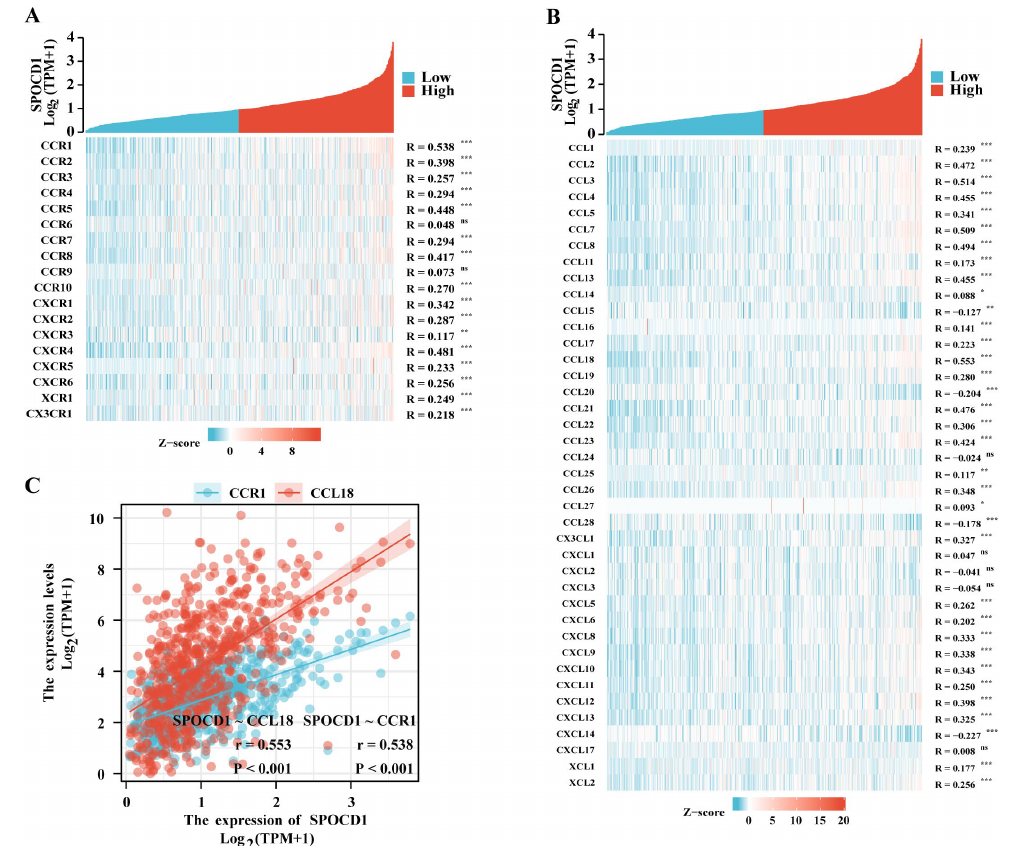
Figure 7. Correlation analysis between SPOCD1 expression and chemokines and chemokine receptors in CRC. ( A ) Heatmap analysis of the correlation between SPOCD1 and chemokine receptors in tumors. ( B ) Heatmap analysis of the correlation between SPOCD1 and chemokines in tumors. ( C ) Correlation between SPOCD1 expression and chemokines CCL18, chemokine receptors CCR1 in CRC (ns represents no significance, * p < 0.05, ** p < 0.01, *** p < 0.001).